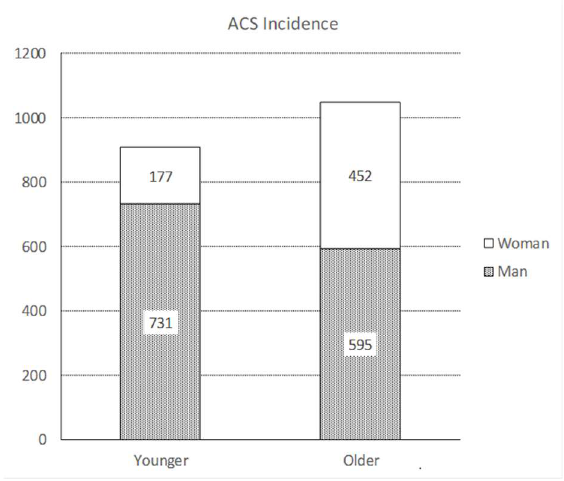
Figure 1. Number of ACS events varied by age and gender group.